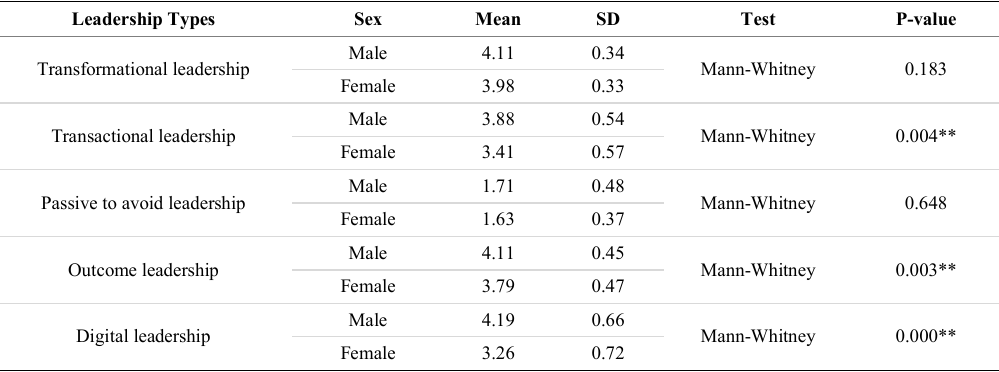
Table 4. Leadership Types per Sex.